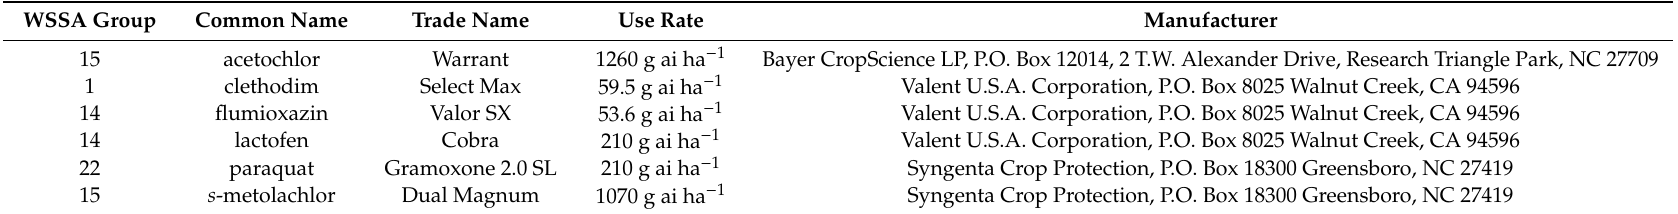
Table 1. Herbicides used in this study.